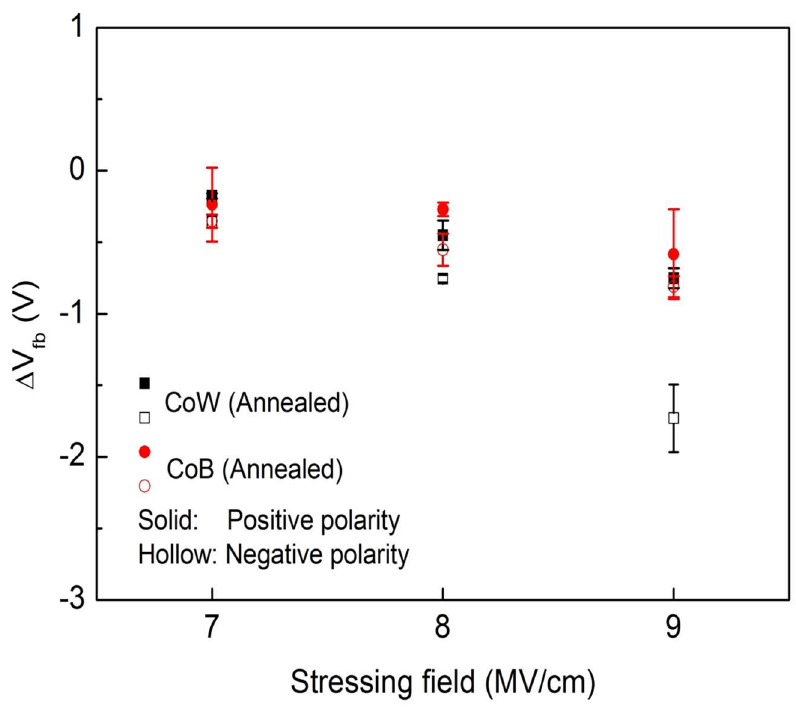
Figure 7. V fb shifts of annealed CoW-gate and CoB-gate MIS capacitors after electrical stress as a function of stress field.